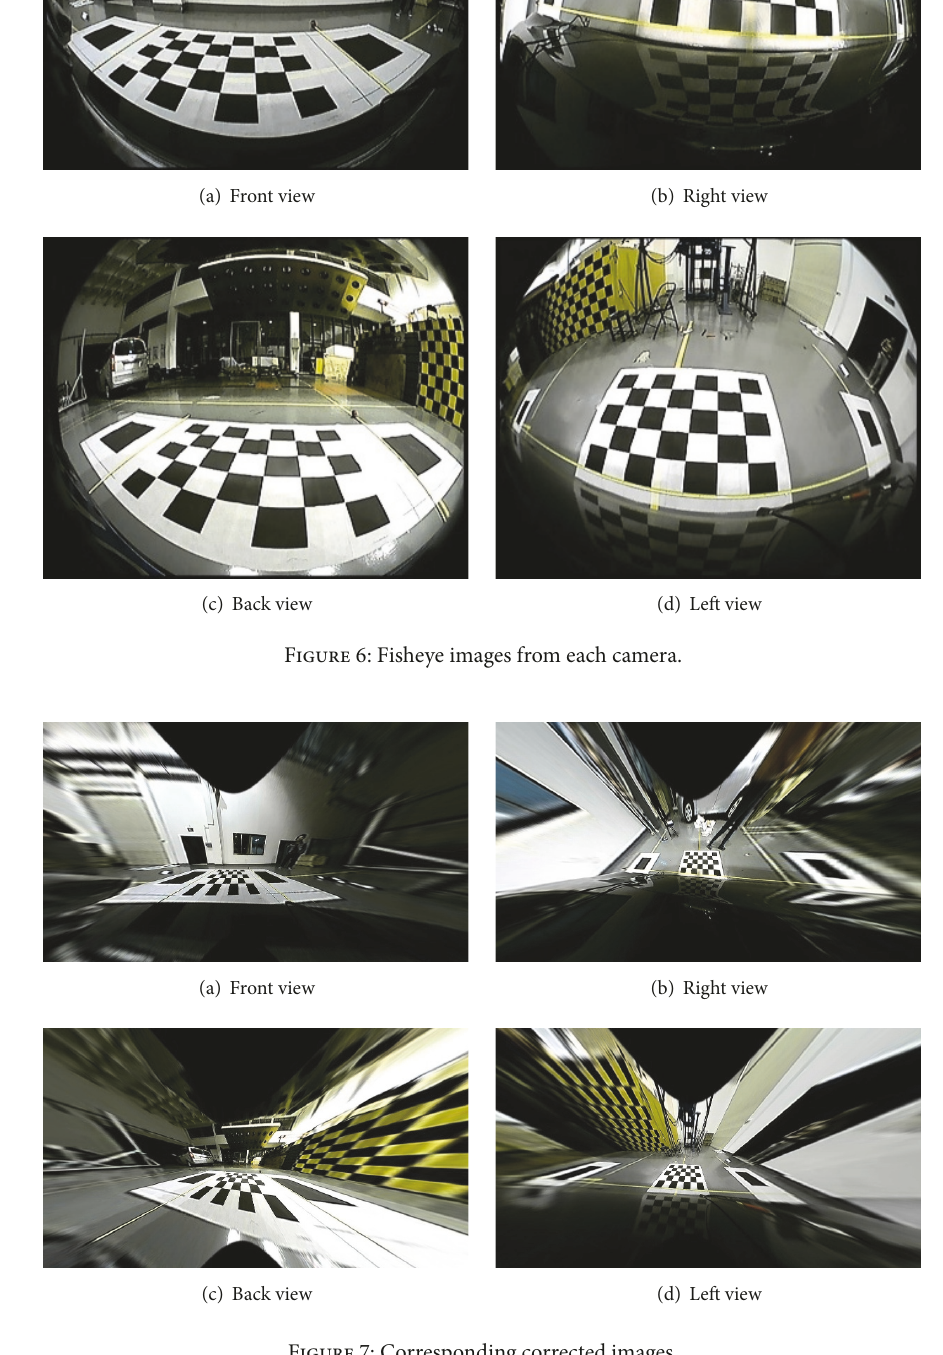
Figure 7: Corresponding corrected